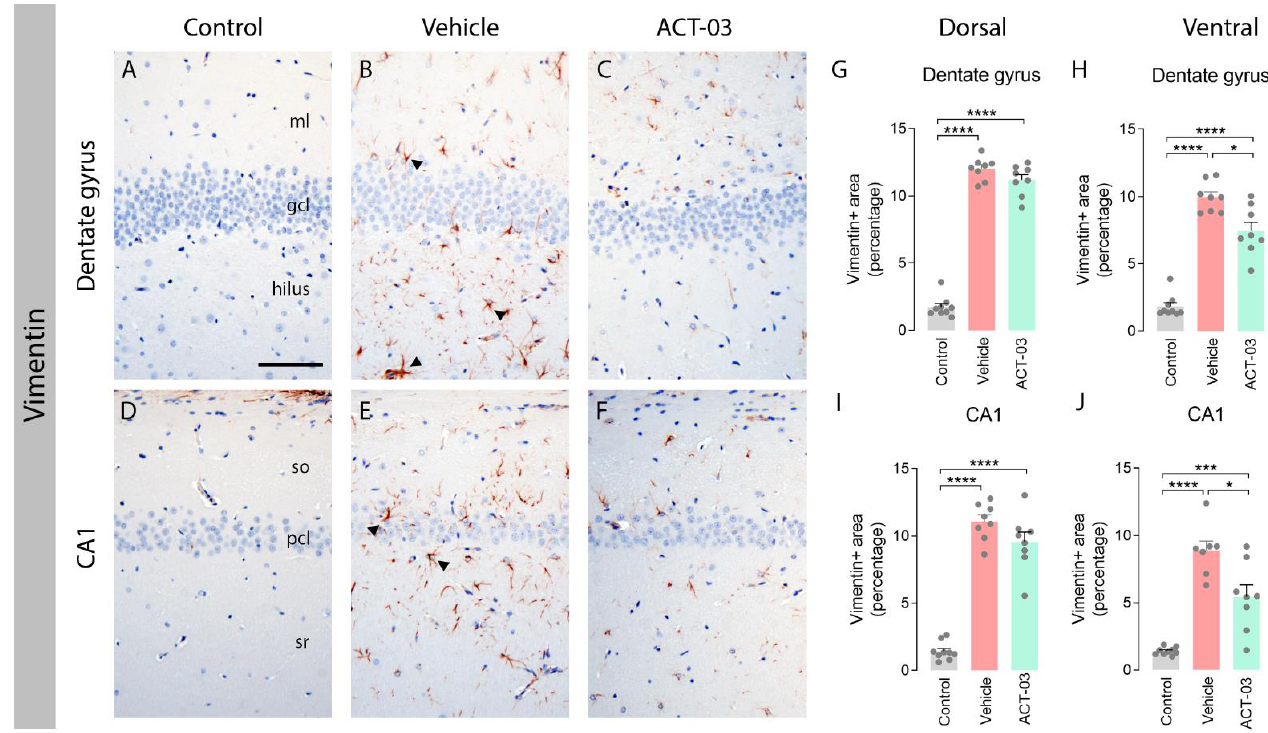
Figure 2. Increased astrogliosis after kindling is ameliorated by ACT-03 treatment. ( A – F ) In non- kindled control animals, vimentin immunoreactivity (IR) was not observed in the parenchyma ( A , D ), while vimentin-positive astrocytes with coarse processes and a reactive morphology (arrowheads) were observed in the hippocampus of kindled, vehicle-treated animals ( B , E ). In kindled animals treated with ACT-03, vimentin-positive cells were sparsely present and displayed less of a reactive morphology ( C , F ). ( G – J ) Quantification shows a larger vimentin-positive area in the dorsal and ventral dentate gyrus (DG) and CA1 area of kindled animals compared to non-kindled animals ( p < 0.001). The vimentin-positive area in kindled, ACT-03-treated animals was smaller compared to kindled, vehicle-treated animals in the DG and CA1 of the dorsal hippocampus ( p < 0.05). Scale bar in A for A–F; 100 µ m; hematoxylin counterstained; ml, molecular later; gcl, granular cell layer; so, stratum oriens; pcl, pyramidal cell layer; sr, stratum radiatum. Bar graphs display mean + SEM, with individual values as dots; *, p < 0.05; ***, p < 0.001; ****, p <